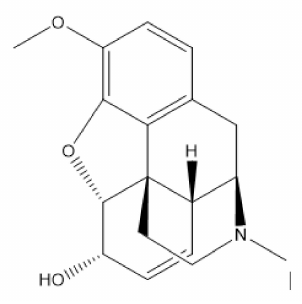
Figure 1. Structure of